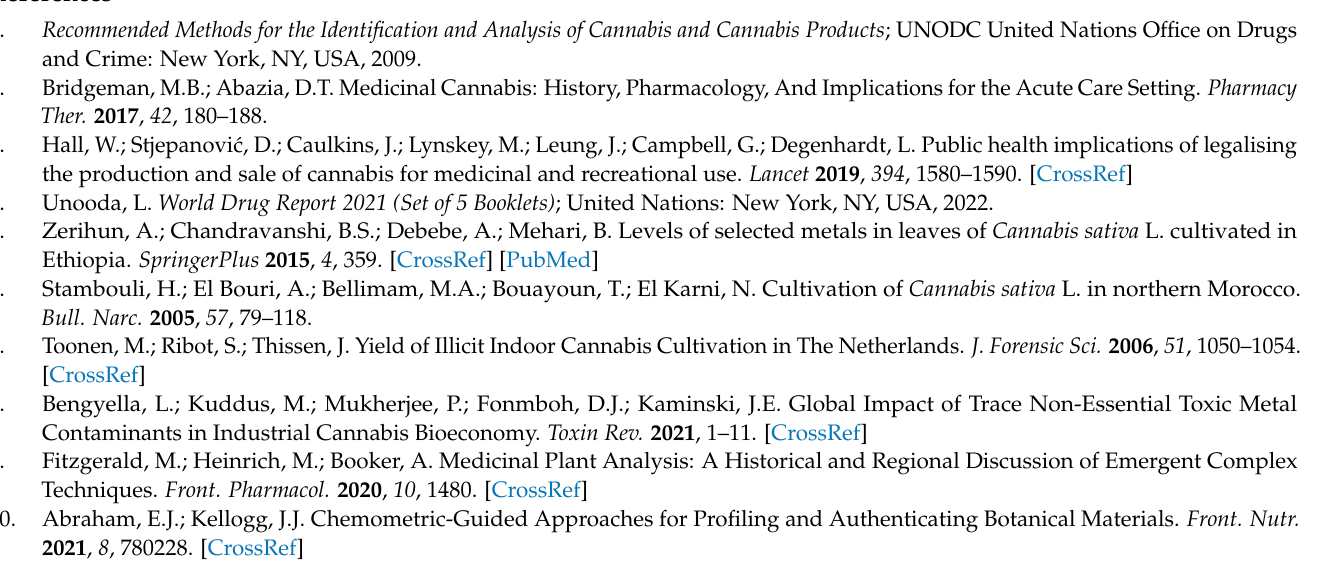
ICP-MS operational parameters. Table S5. Essential Elements Cannabis Sample Concentrations in ( µ g g − 1 ). Table S6. Heavy Metals Cannabis Sample Concentrations in (ng g − 1 ). Table S7. Soil Sample Concentrations in ( µ g g − 1 ), As and Pb (ng g − 1